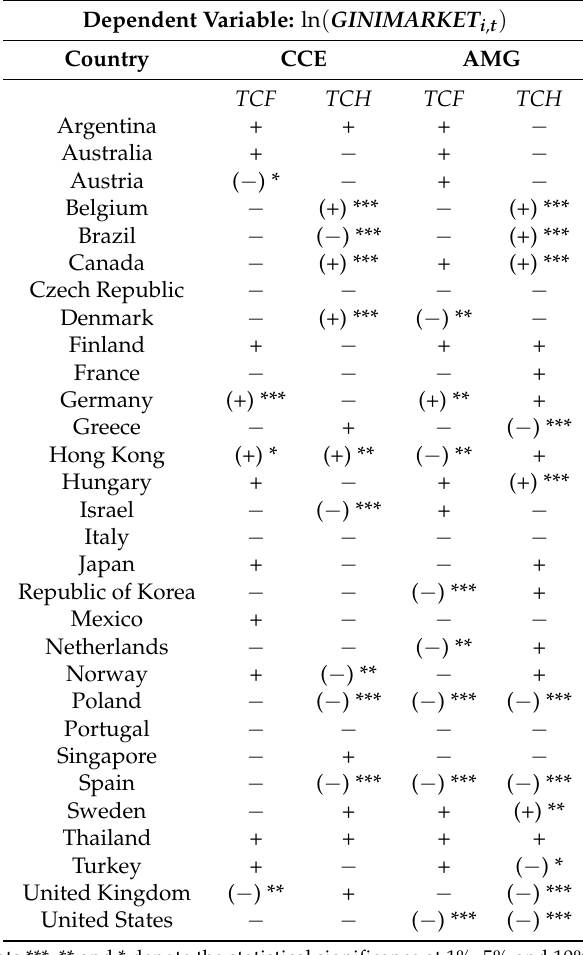
Table A1. Country-Specific Regressions (Summary of the Sign of the Coefficients). Dependent Variable: ln ( GINIMARKET i , t